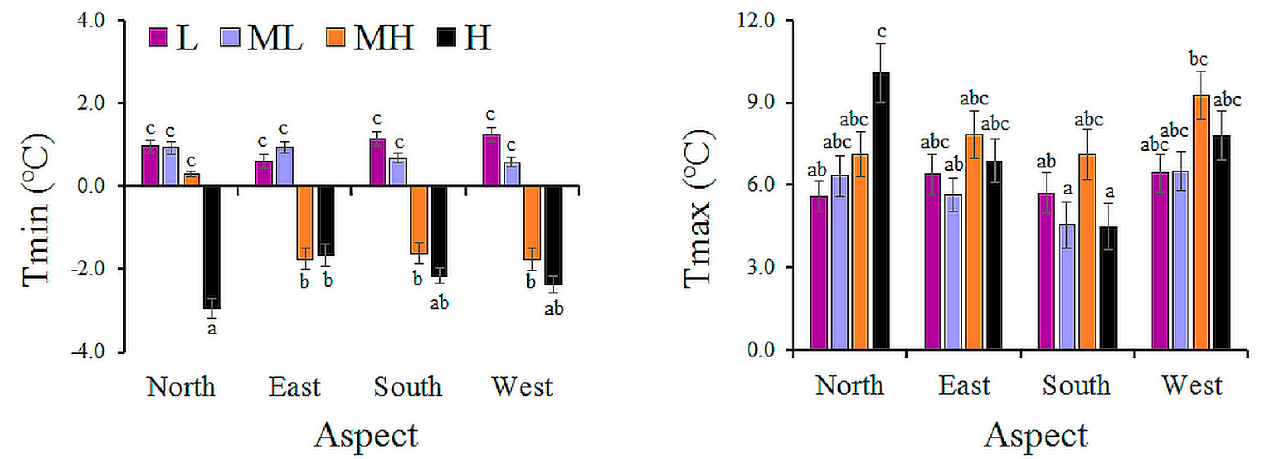
Figure 4. Interaction graphs of elevation × cardinal aspect including the entire five annual period data, for monthly absolute minimum (Tmin) and maximum (Tmax) temperatures (°C) in the South Patagonian mountain site immersed in forest landscape (Tierra del Fuego), according to three-way ANOVA results shown in Table 5 (n = 12; N = 720 for Santa Cruz and N = 960 for Tierra del Fuego). Elevation: L = low, ML = medium-low, MH = medium-high, H = high; cardinal aspect: north, east, south, west. Error bars represent ± standard error. Different letters in each graph indicate significant differences ( p < 0.05) by the Tukey test.